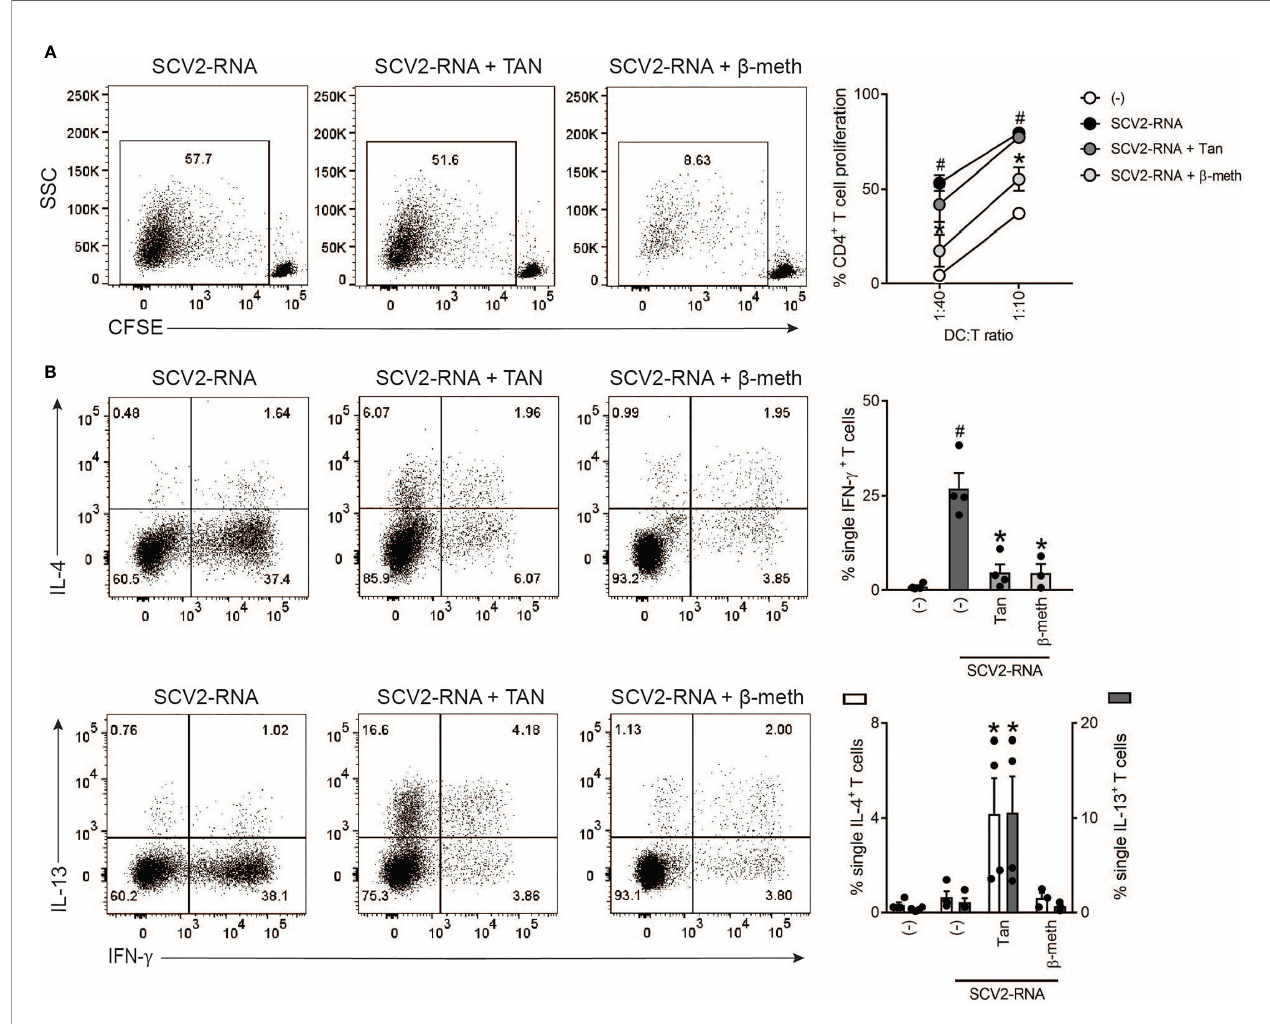
FIGURE 4 | Effect of Tanimilast on CD4 + T cell activation by moDCs. (A) moDCs were treated or not (-) with Tanimilast (Tan) or b -methasone ( b -meth) (both at 10 -7 M) for 1 hour before stimulation with SCV2-RNA. After 24 hours, moDCs were collected and co-cultured with graded numbers of CFSE-stained allogenic CD4 + T cells for 6 days. Alloreactive T cell proliferation was assessed by measuring CellTrace-CFSE dye loss by fl ow cytometry. Left, dot plot from one representative experiment (1:40 ratio). Right, line graphs from four independent experiments with different DC:T cell ratio. Data are expressed as mean ± SEM (n=4) of the percentage of proliferating CD4 + T cells. (B) Activated moDCs were incubated with graded numbers of T cells for 6 days. Intracellular IFN- g , IL-4 and IL-13 were evaluated by FACS analysis. Left, dot plot from one representative experiment. Right, bar graphs from four independent experiments. Data are expressed as mean ± SEM (n=3-4) of single IFN- g - (upper right panel) or single IL-4- (right Y axis) and IL-13- (left Y axis) (lower right panel) producing T cells. (A, B) # P< 0.05 versus (-) and *P< 0.05 versus SCV2-RNA by one-way ANOVA with Dunnett ’ s post-hoc